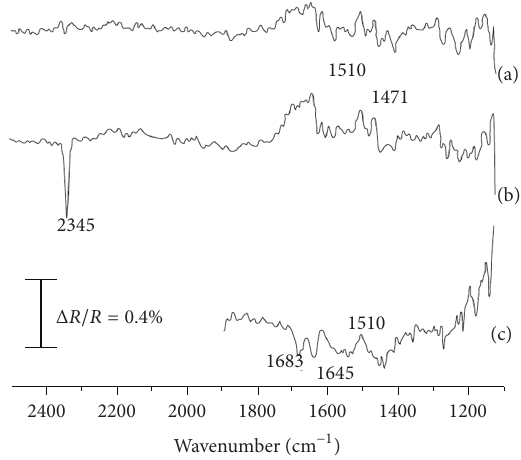
F 5: FTIR spectra for a Pt electrode in a 1M HClO